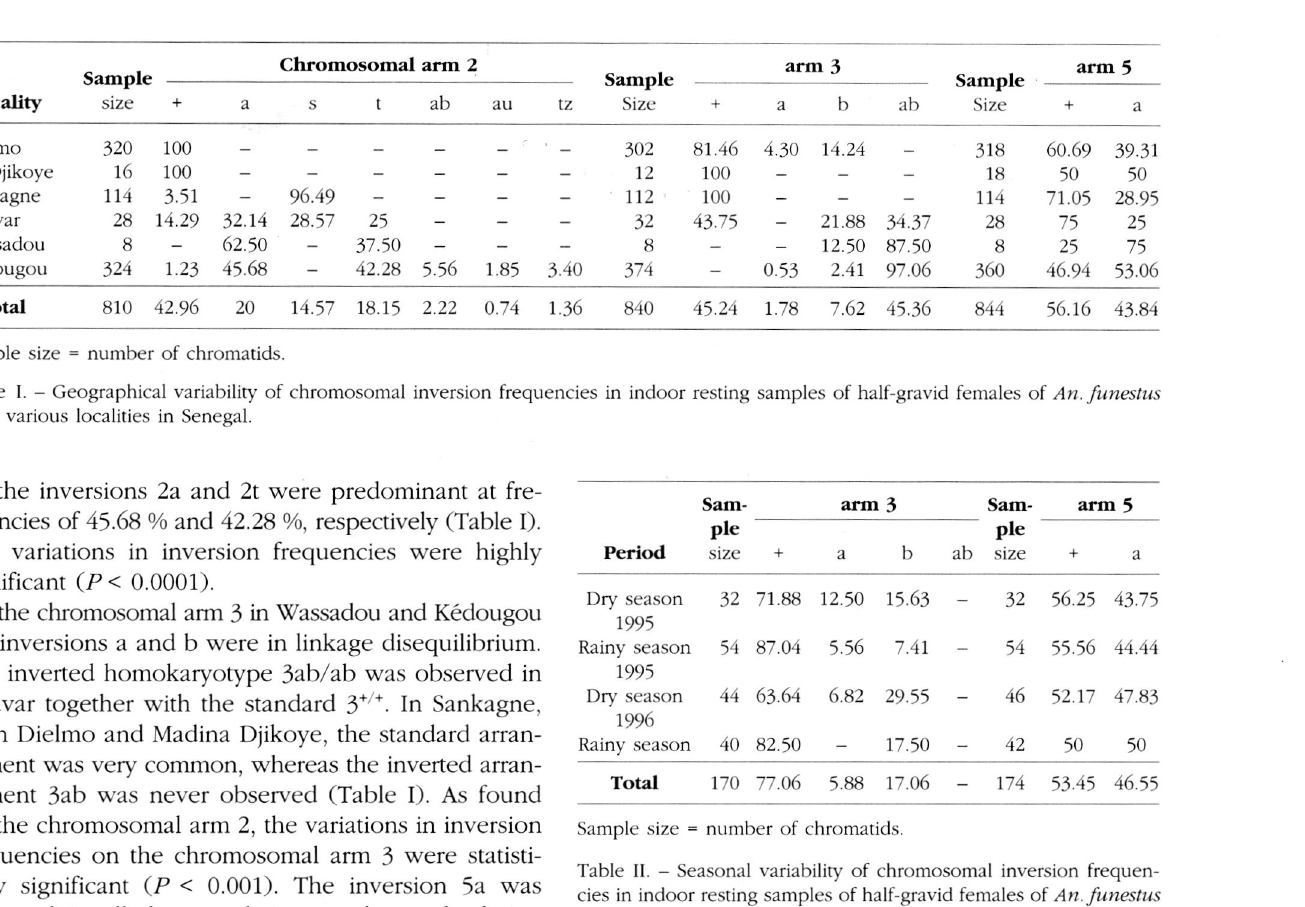
Table II. - Seasonal variability of chromosomal inversion frequen cies in indoor resting samples of half-gravid females of An. funestus from